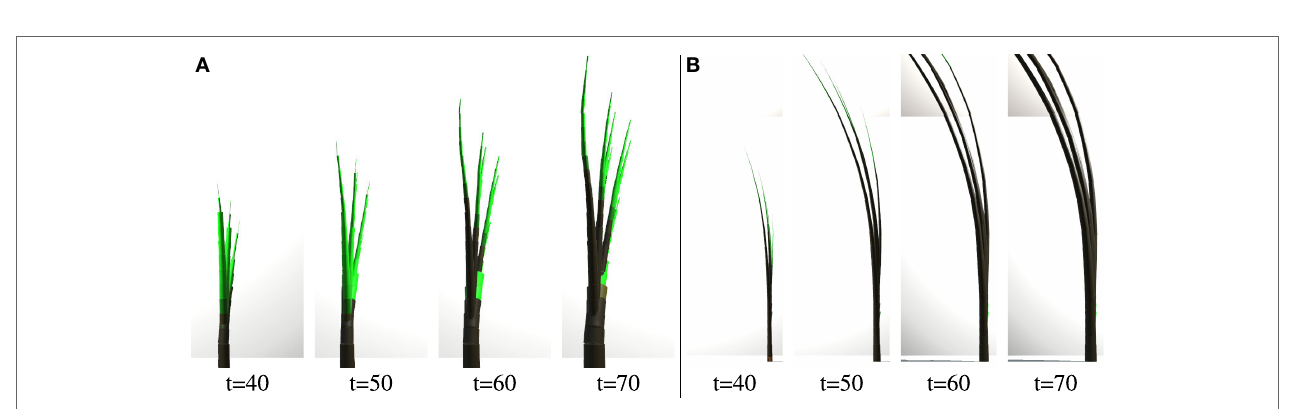
FigUre 5 | Screenshots of two swarm grammars specifically illustrating lignification and bending at simulation time step t . (a) Lignification and (B) bending.